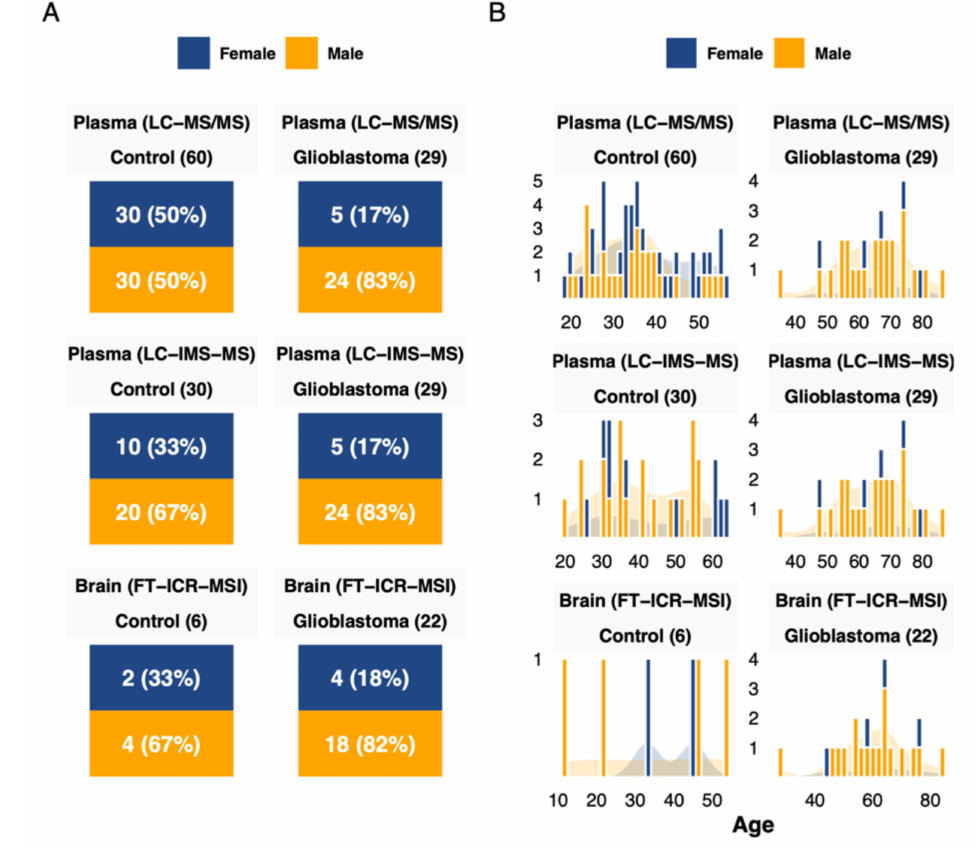
Figure 1. Cohort overview. ( A ) Cohort description and sex distribution related to each dataset. ( B ) Age distribution by sex and